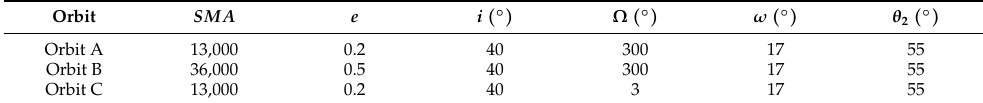
Table 7. Exemplar orbits for qualitative